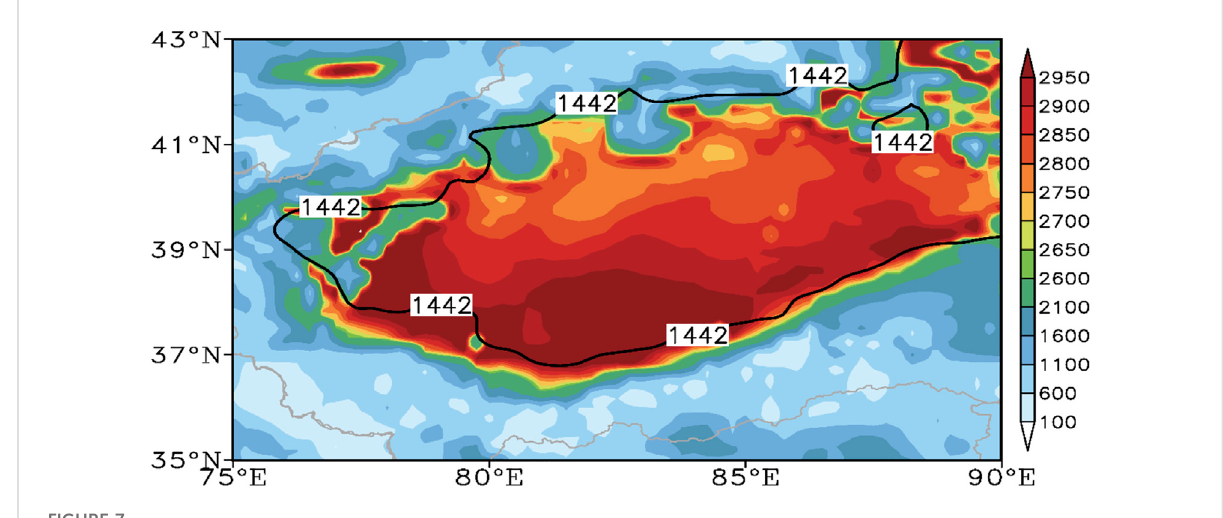
FIGURE 7 Spatial distribution of evapotranspiration in the Tarim Basin based on ERA-5 fi ne grid data (the black line denotes the boundary of the Tarim